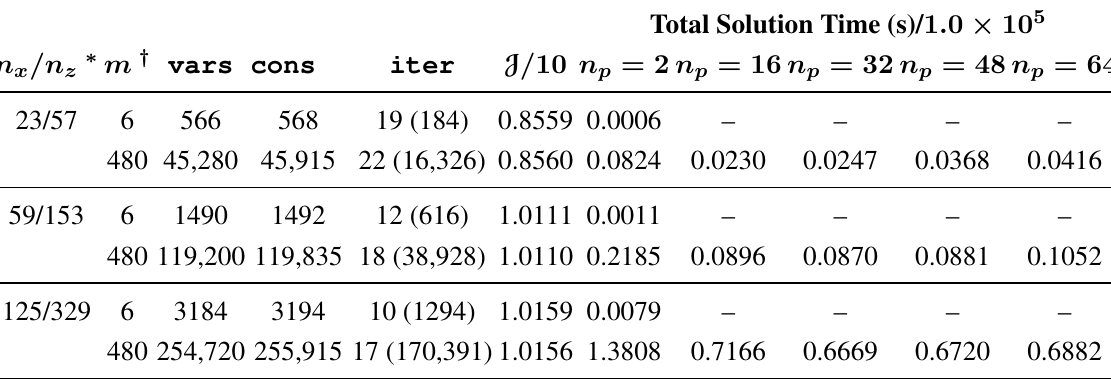
Table 4. Case Study 2: parallel computation results comparing different DAE dimensions.